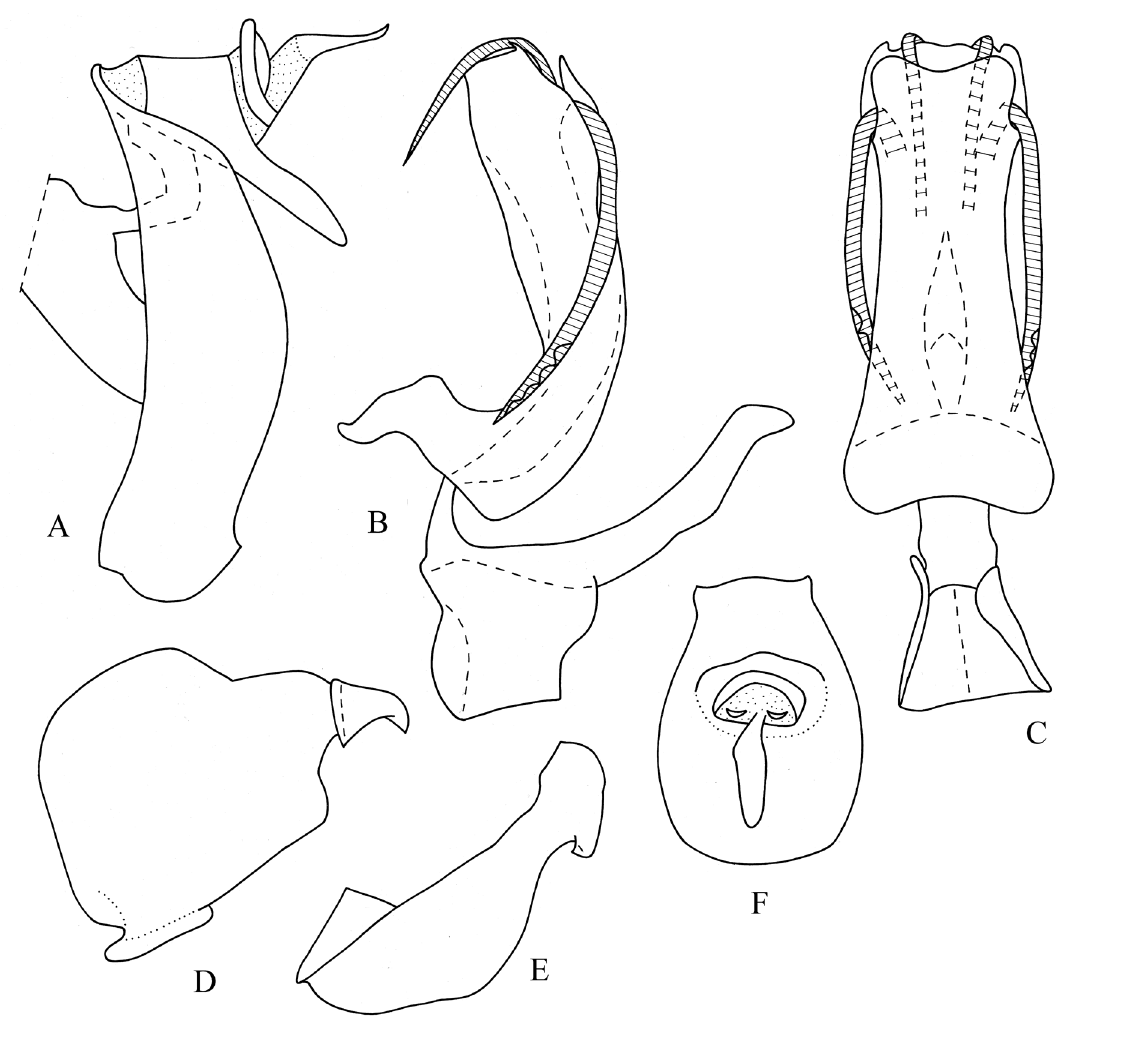
Fig. 6. Superciliaris celebensis sp. nov., ♂, holotype (BMNH), genitalia. A . Pygofer, anal tube, and basal part of penis, lateral view. B . Penis and connective, lateral view. C . Penis and connective, ventral view. D . Style, lateral view. E . Style, dorsal view. F . Anal tube, dorsal view. No to